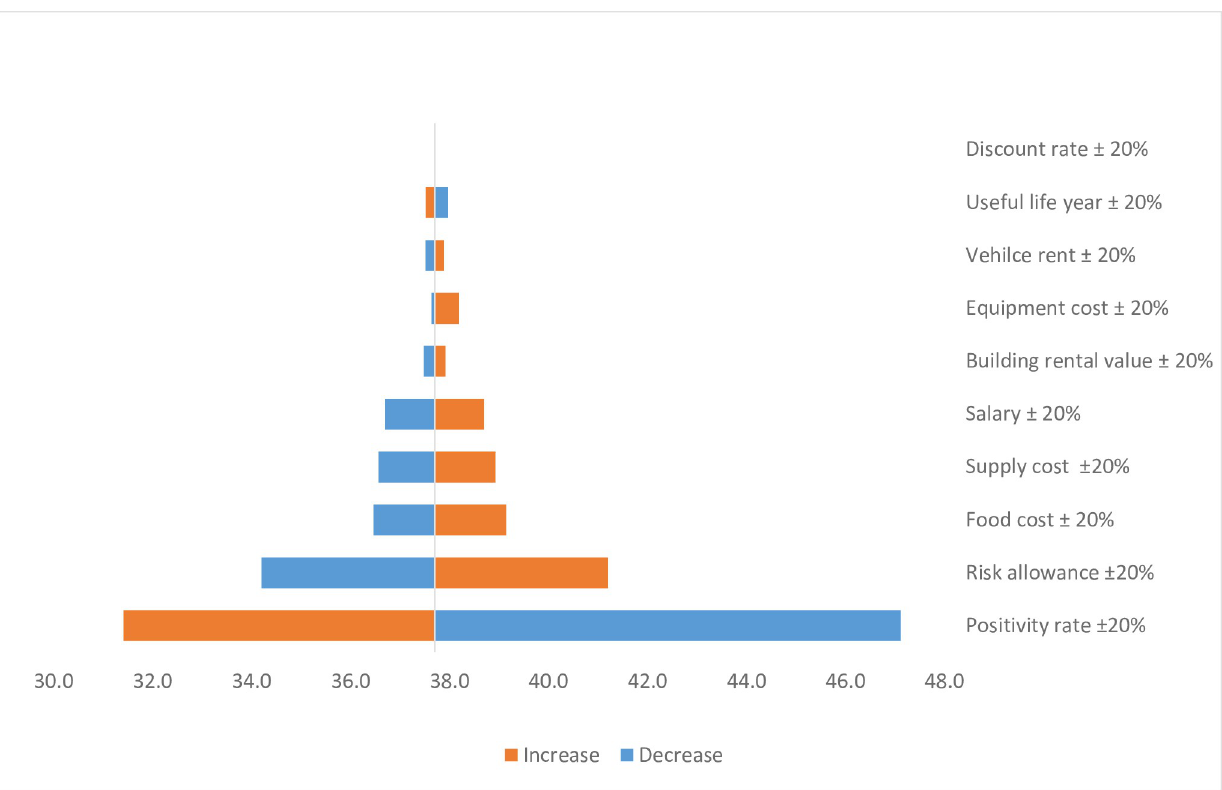
Fig 4. One-way sensitivity analysis on the cost of identifying COVID-19 positives through laboratory diagnosis. N.B: the cost includes only resource use after the sample is transported to the laboratory unit.